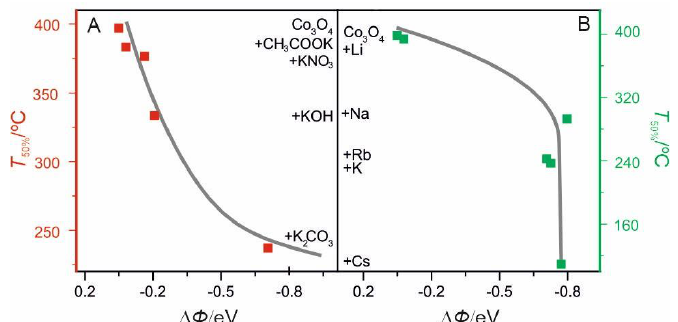
Figure 5. The catalytic activity represented by half conversion temperature of N 2 O decomposition ( T 50% ) against the catalyst work function changes for K-promoted cobalt spinel obtained with different potassium precursors ( A ) and cobalt spinel promoted with Li, Na, Rb, K, and Cs carbonates ( B ). The alkali concentration equals 2 atoms/nm 2 for all samples.